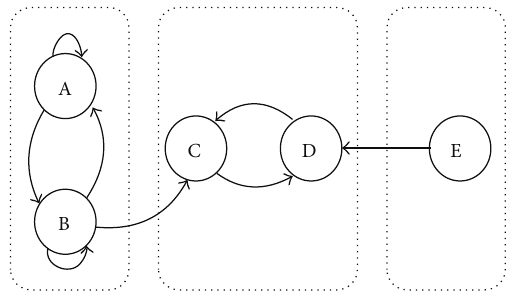
Figure 1: Nodes A, B form an opinion leader SCC, while node C by itself is another opinion leader SCC. Nodes E and D form an opinion follower